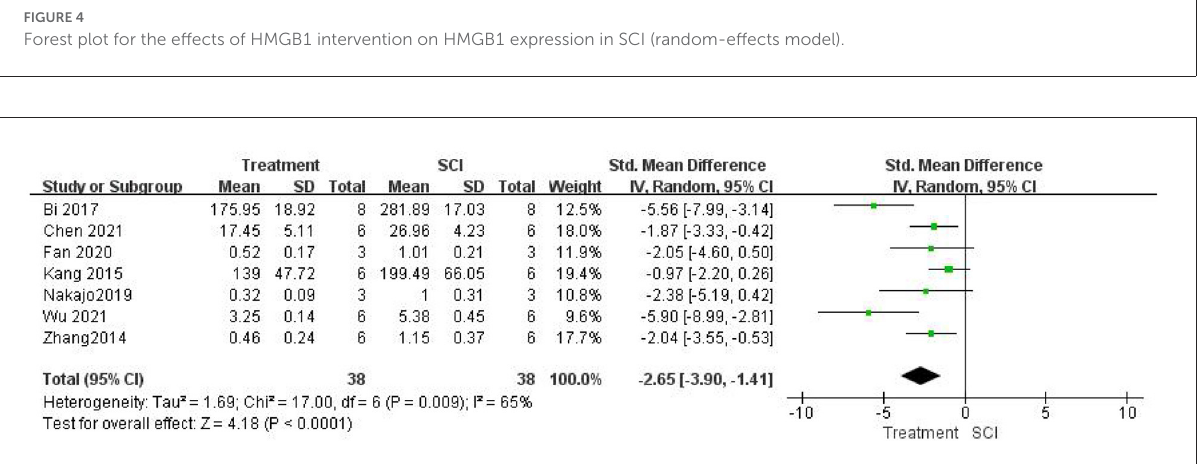
FIGURE5 Forest plot for the effects of HMGB1 intervention on TNF- α levels in SCI (random-effects model).